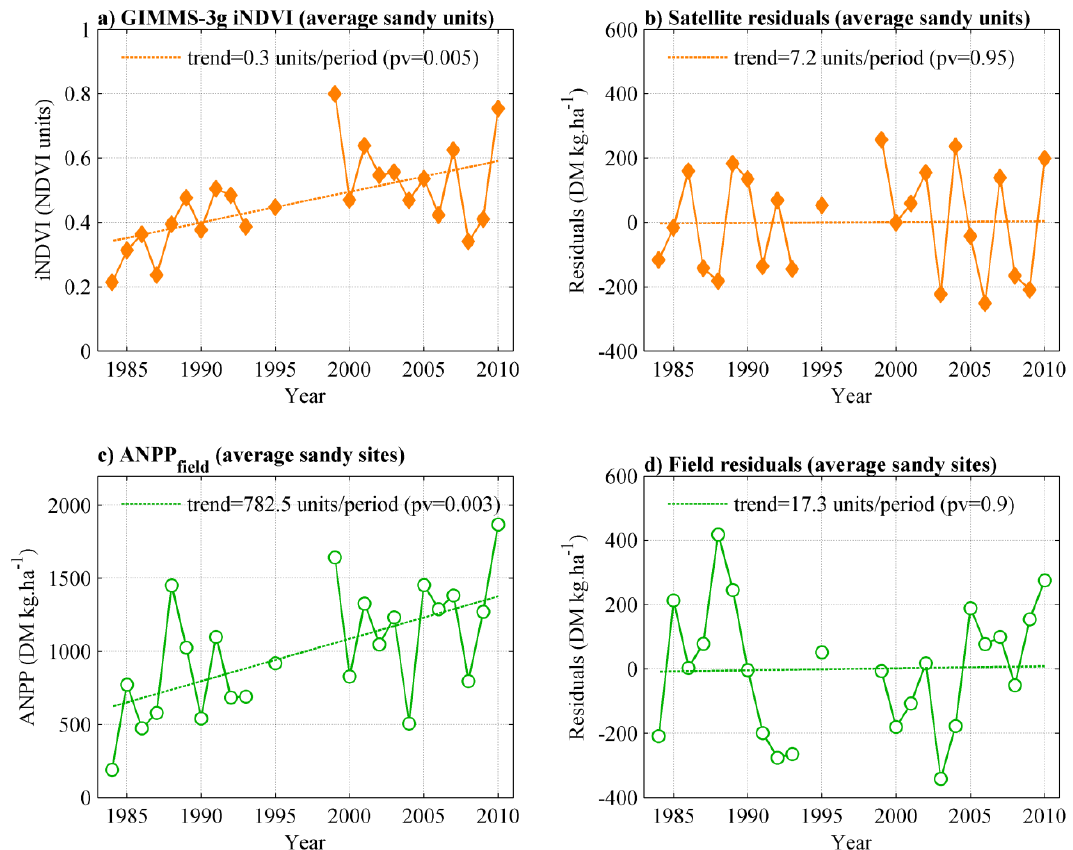
Figure 8. ( a ) ANPP and ( b ) satellite residuals from GIMMS-3g iNDVI averaged over sat the sandy units (Sa and Sa ) displayed in Figure 1. ( c ) ANPP 1 2 obtained from averaged ANPP over the sandy sites in the Gourma window. ANPP residuals are calculated using the mean rainfall over the Gourma region. ANPP increases while the residuals do not show any trend over